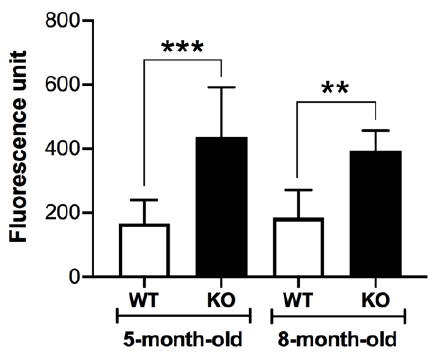
Figure 6. Higher H 2 O 2 levels in Sertoli cells from 5-month-old and 8-month-old Arsa KO mice, as compared with Sertoli cells from age-matched WT counterparts. Results were from 3 replicate experiments. **, *** denote p < 0.01 and 0.001, respectively.